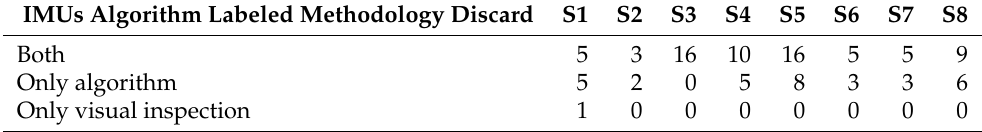
Table 2. Table with the comparison between the discard algorithm and the visual inspection. In the first row, number of repetitions in which the criterion coincided between the algorithm and the visual inspection; in the second row number of repetitions in which the criterion was only applied by the algorithm; in the second row, number of repetitions in which the criterion was only applied in the visual